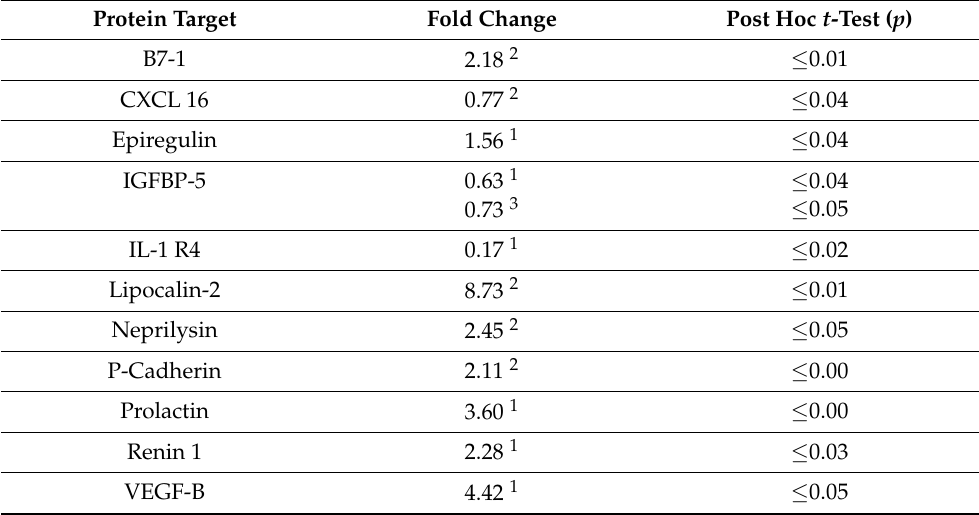
Table 2. Differentially expressed plasma proteins in Fmr1 KO mice dependent on